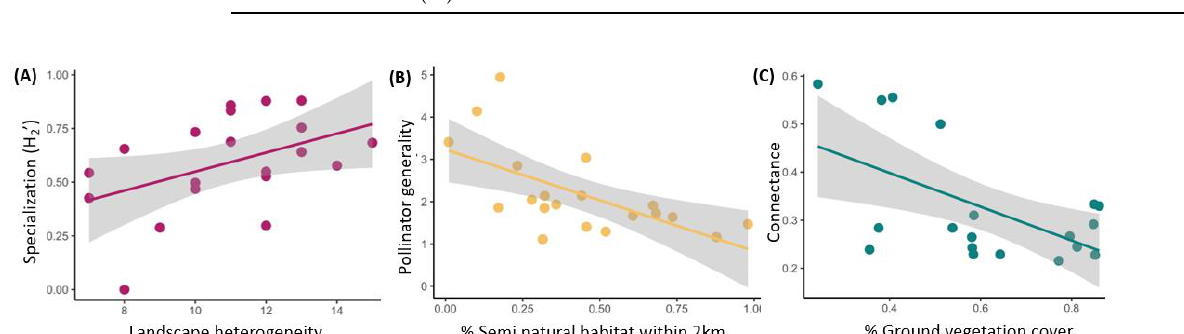
Figure 1. The significant relationships between the local and landscape factors and plant-pollinator network metrics: ( a ) landscape heterogeneity impacts on specialization, ( b ) % semi-natural habitat impacts on pollinator generality, and ( c ) % ground vegetation cover impacts on connectance. Grey shading represents 95% confidence intervals.